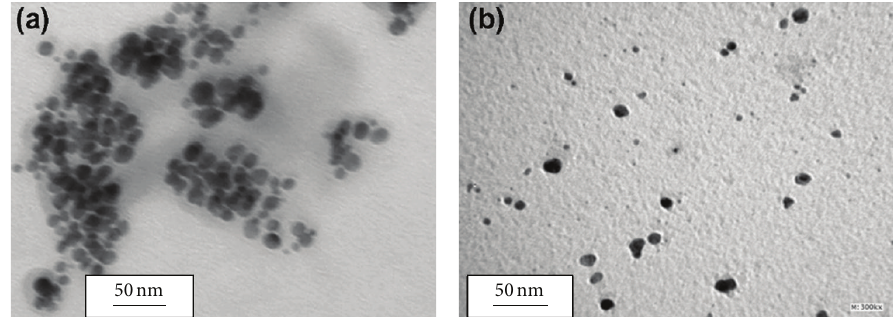
Figure 7: TEM micrograph of the silver nanoparticles [48]: (a) at pH 3, nm and (b) at pH 8 (reproduced with permission from the journal).